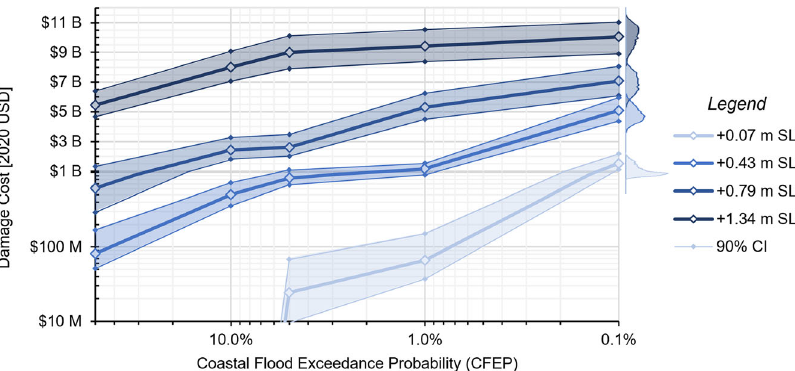
Fig. 3 Flood damage costs [2020 USD] vs. coastal fl ood exceedance probability (CFEP) under the four sea level rise (SLR) conditions assessed. Expected values (thick line) and 90% con fi dence interval (shaded region) of coastal fl ood damage costs under + 0.07 m SLR (light blue), + 0.43 m SLR (blue), + 0.79 m SLR (dark blue), and + 1.34 m SLR (navy blue). SLR values speci fi ed relative to a year 2000